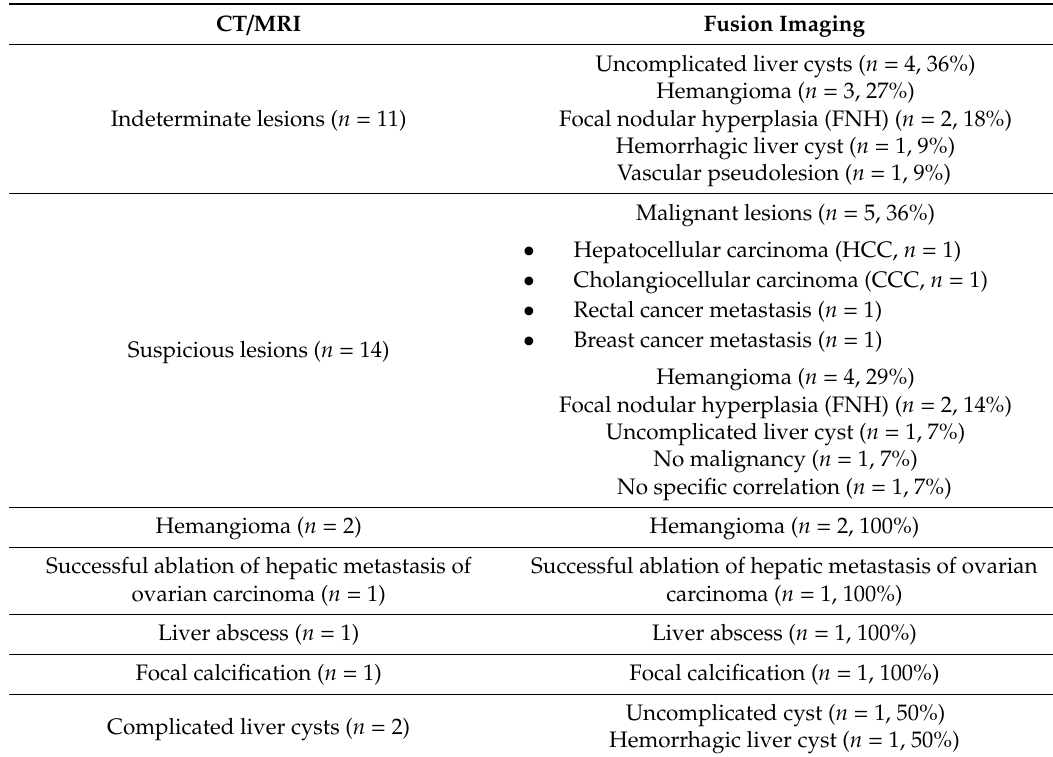
Table 1. Overview of findings from cross-sectional imaging (computed tomography / magnetic resonance imaging (CT / MRI)) and corresponding correlates by fusion imaging of 32 patients with focal liver lesions, CT-computed tomography, MR-magnetic resonance imaging. CT / MRI Fusion Imaging Uncomplicated liver cysts ( n = 4, 36%) Indeterminate lesions ( n = 11)